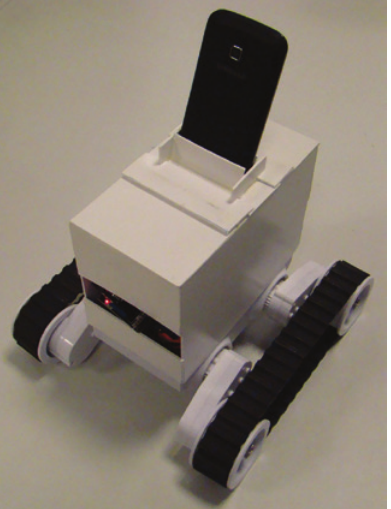
Figure 2: The Web-Controlled Home